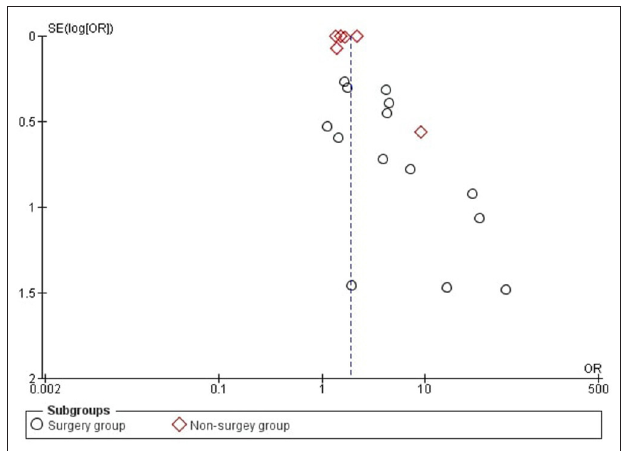
FIGURE 2 | Funnel plot which is used to demonstrate publicaion